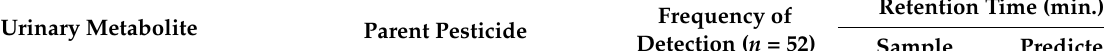
Table 1. Cont. Table 1. Suspect analysis of human urinary metabolites in influent wastewater sampled in Athens between 2014 and 2020.